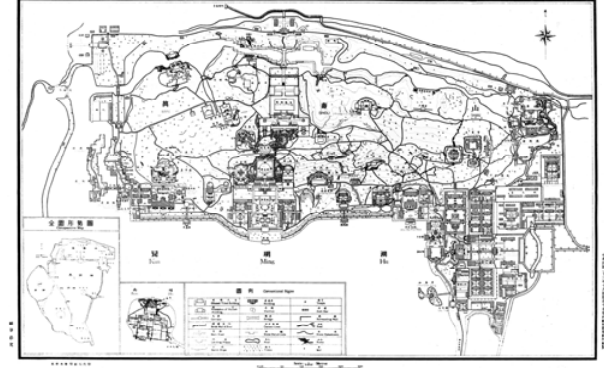
Fig. 4. A General Plan of the Summer Palace, 1934 (From: Administrative office of the Summer Palace)